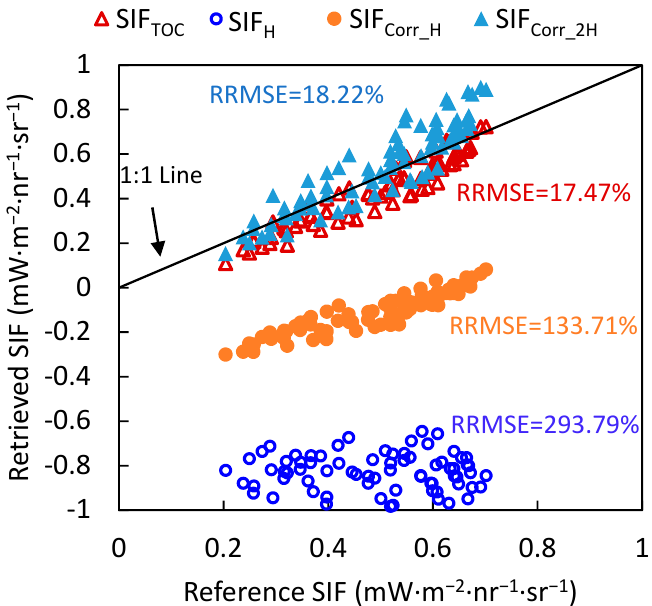
Figure 7. The relation between the modelled reference SIF and the modelled SIF retrieved by the 3FLD method using different atmospheric correction methods. SIF TOC is the SIF retrieved using radiation simulations at the top of the canopy; SIF H is the tower-based SIF retrieved using original spectral simulations at a height of H (20 m) without atmospheric correction; and SIF corr_H and SIF corr_2H are the tower-based SIF retrieved using atmospherically corrected spectra and RTPL values of H and 2H, respectively.